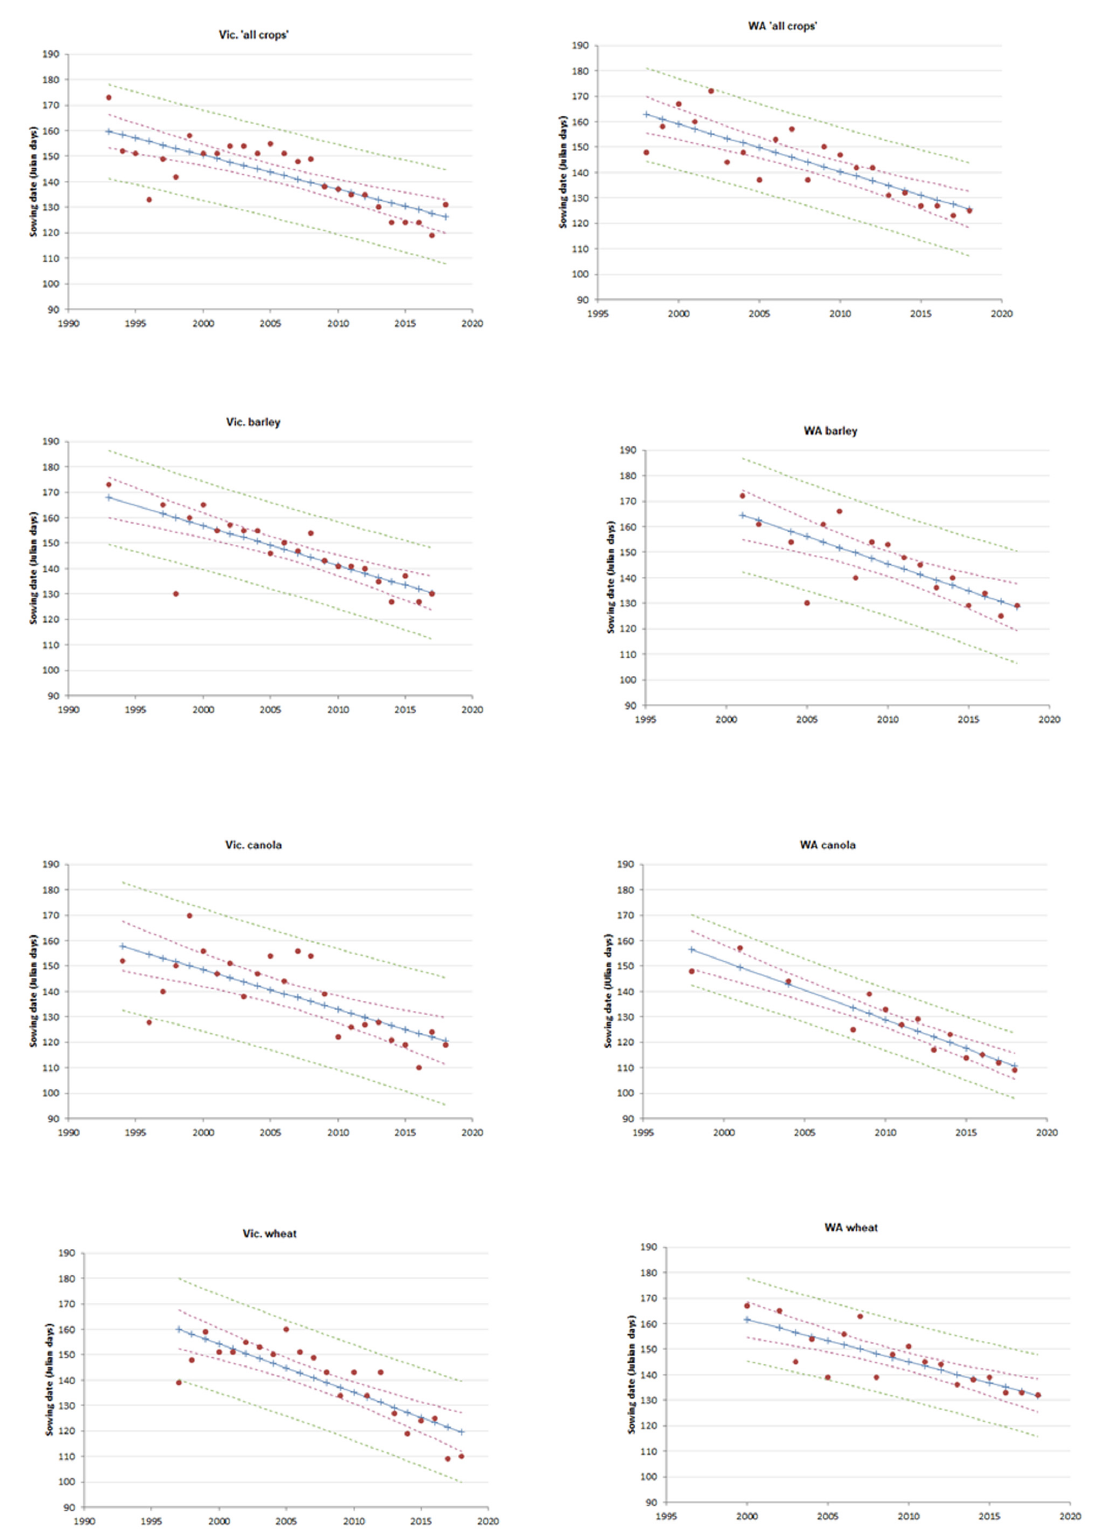
Figure 2. Correlations between mean sowing date and year for state × crop type combinations (>30 trials, R 2 >0.50). The category of ‘all crops’ included barley, canola, chickpeas, faba beans, field peas, lentils, linseed, lucerne, lupins, mustard, oats, kaspa peas, triticale, vetch and wheat. Blue line indicates predicted SD, dashed red lines indicate 95% confidence intervals, and green dashed lines indicate 95% prediction intervals.